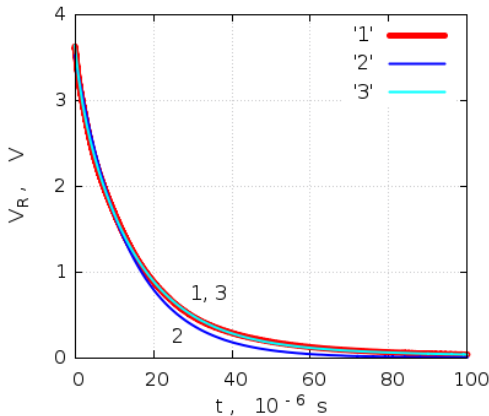
Figure 5: Transmission spectra of setup #3 at different light intensities ( V LED = 39 , 33 , 31 , 30 , 20 V, curves 1 to 5, re- spectively).